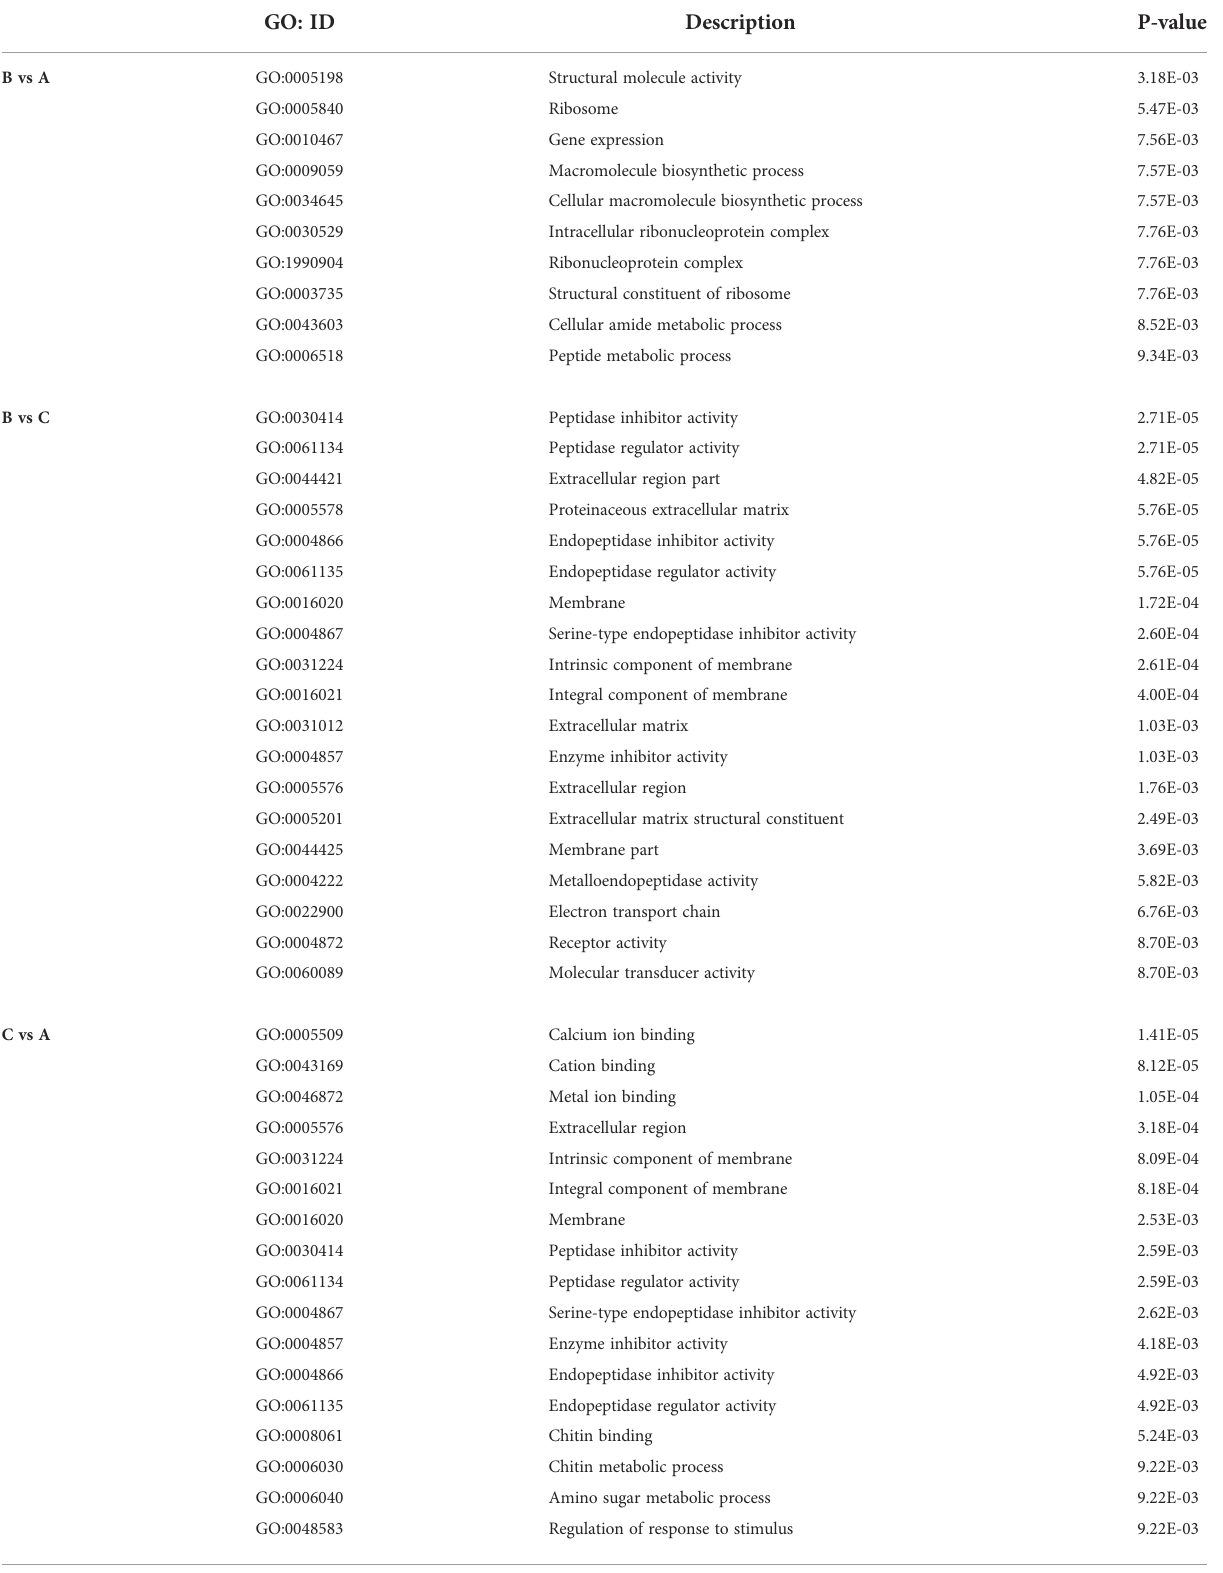
TABLE 2 GO enrichment for DEPs ( P <